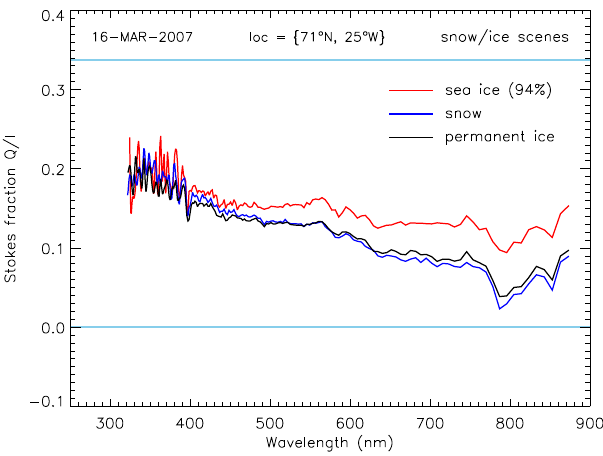
Figure 10. Stokes fraction Q/I for cloud-free scenes over snow Fig. 10. Stokes fraction Q/I for cloud-free scenes over snow (blue), permanent ice (black), (blue), permanent ice (black) and sea ice and sea ice (red).